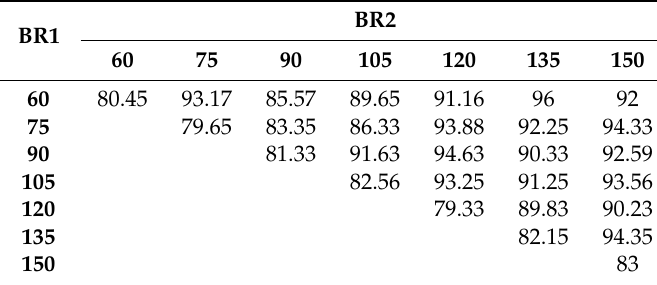
Table 12. Feature fusion detection accuracy—FAAC-NeroAAC